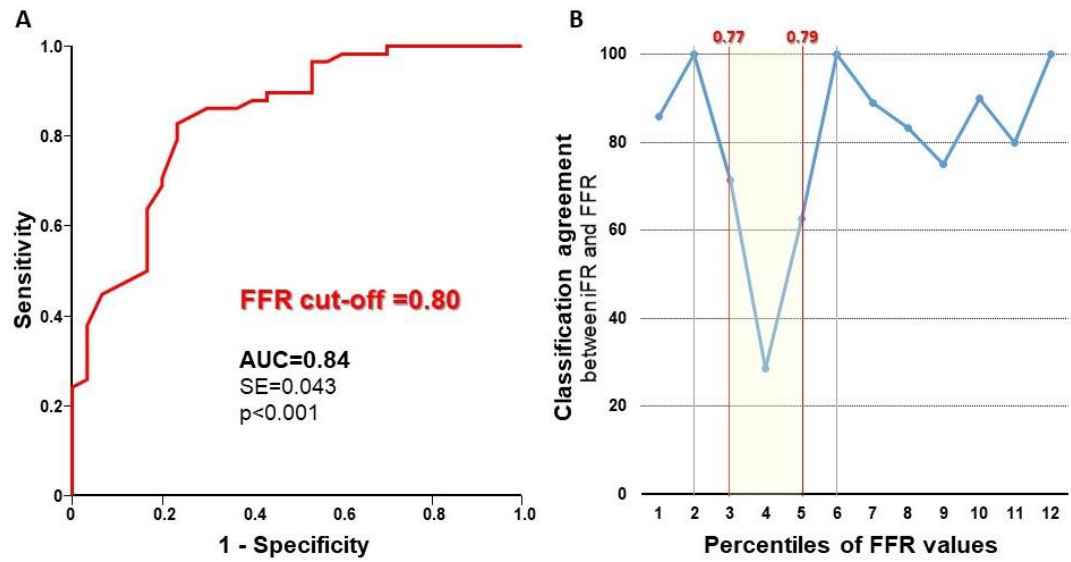
Figure 2. Diagnostic performance of the iFR . Panel A . Receiver operating characteristic (ROC) curve analysis demonstrates an excellent performance of the iFR to detect FFR-positive stenoses. Panel B . V-plot (V-shaped plot) depicting the classification agreement between the iFR and the FFR across the percentiles of FFR values measured in the study.